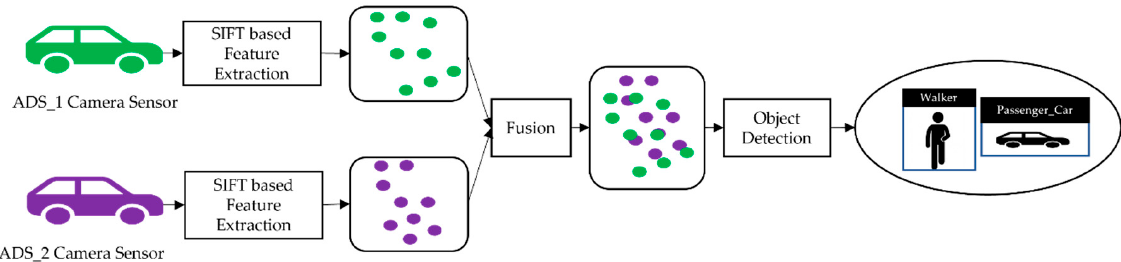
Figure 3. Collaborative perception systems and joint object detection based on Faster R-CNN.